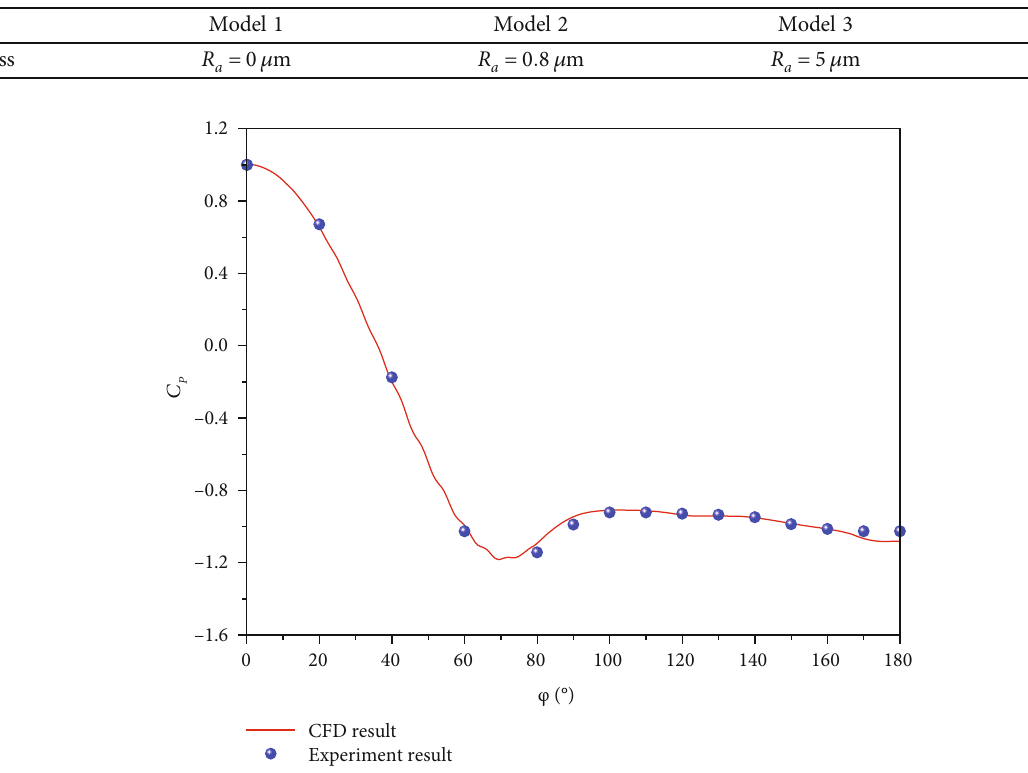
Figure 4: Comparison diagram of numerical simulation results and experimental values of smooth cylinder mean pressure coe ffi cient distribution at